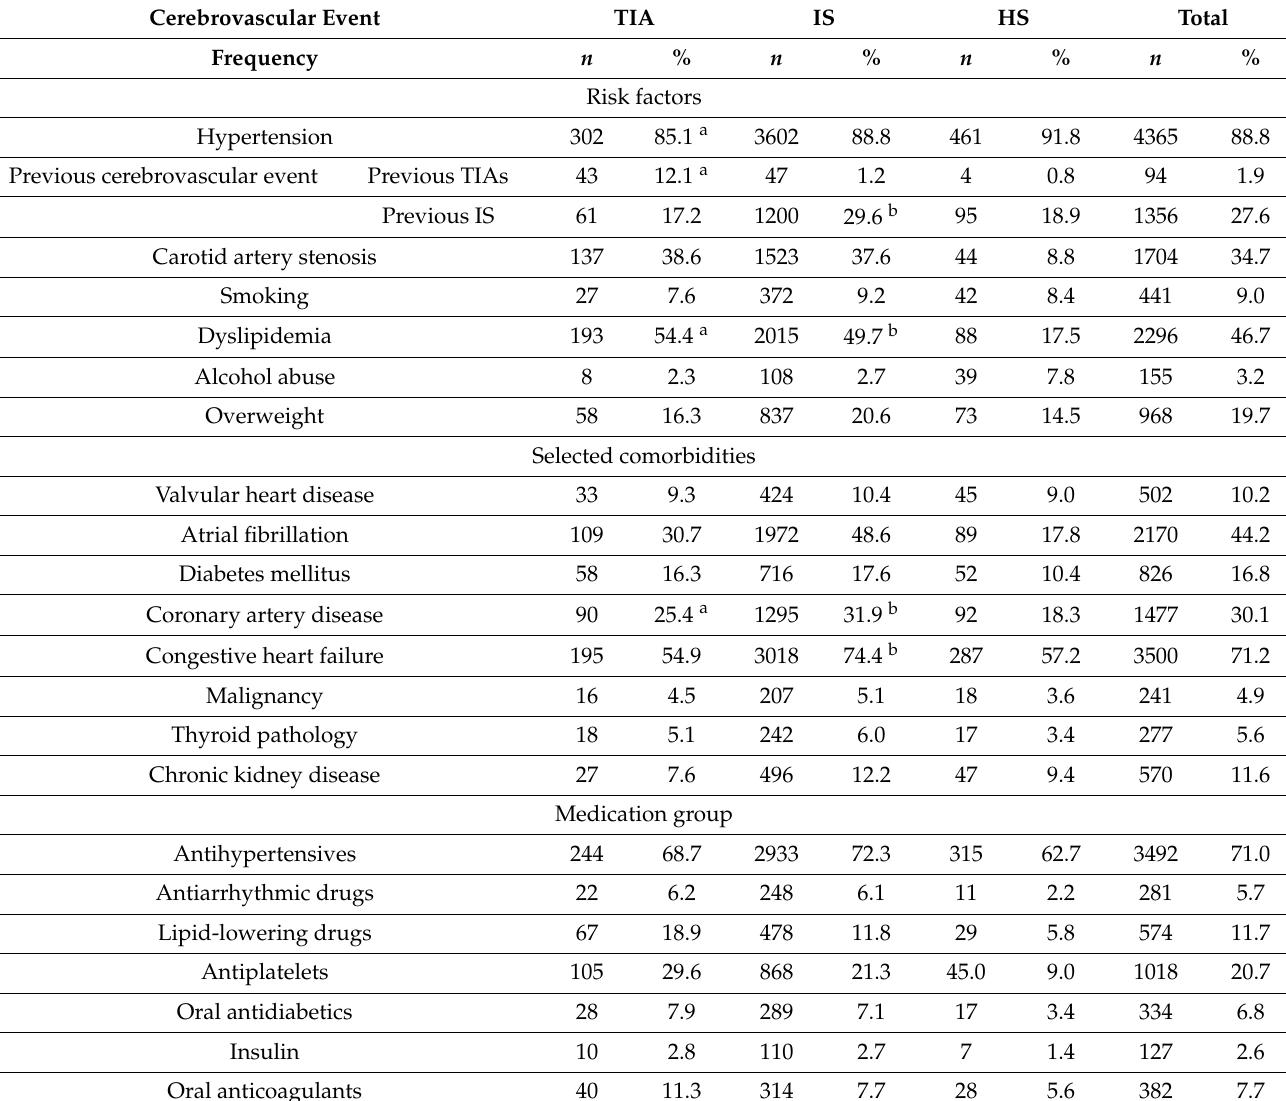
Table 4. Comparison of frequency by chi-square test of the risk factors, comorbidities, and medications used before hospitalization between TIA, IS, and